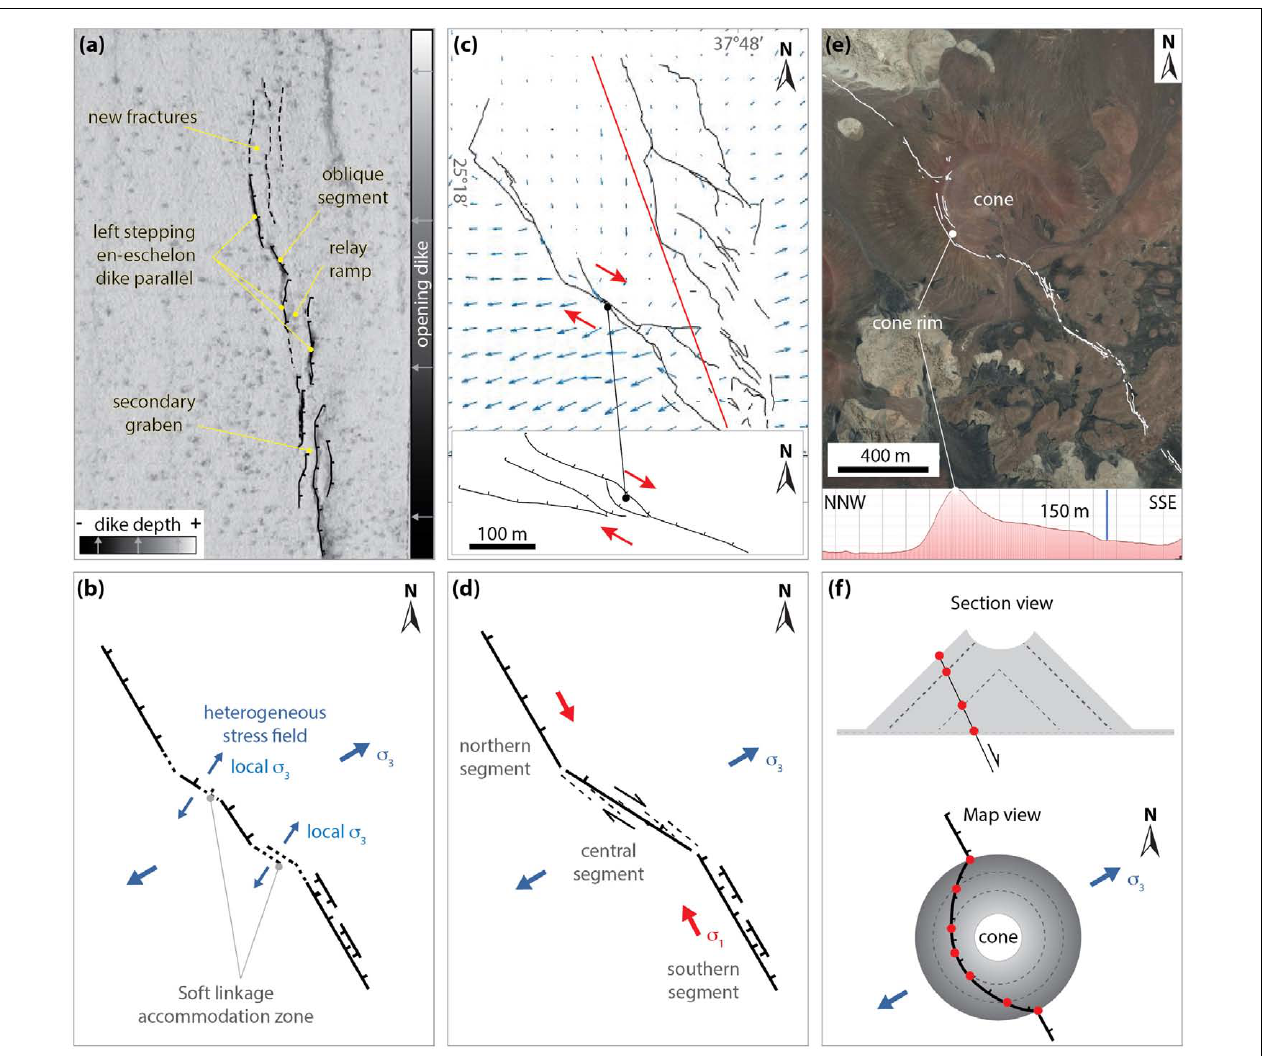
FIGURE 11 | Kinematic interpretation of the western fault pattern. (a) Fracture pattern (black lines) in map view from the analog model by Xu et al. (2016); dataset from Corbi et al., 2019 EPOS repository), (b) Schematic figure of the accommodation zone in which σ 3 can be locally re-oriented at the tips of the overlapping faults. (c) Horizontal displacement vectors (blue arrows) and fractures (black lines) mapped using InSAR data in the area affected by the 2009 dike intrusion (Jónsson, 2012). The inset shows the main fault branches near the northern tip of segment H (see also Figure 4b ). Red arrows indicate the inferred sense of the shear component of motion. (d) Schematic model of the major segments of the western fault (see also Figure 2 ) along with the inferred σ 3 orientation. Black solid lines represent the dike parallel faults whereas dashed lines are en-echelon fractures on the oblique segment. (e) Western fault pattern (white line) and topography along the fault where it passes through the volcanic cone. (f) Schematic model of the topographic effect induced by a cone on an ideal 75 ◦ normal fault. Section view (above) of the fault intersecting a cone of different heights (dashed lines), with red dots indicating locations where the fault reaches the surface. Map view (below) showing the fault surface rupture across the cone (gray shaded) and the overall σ 3